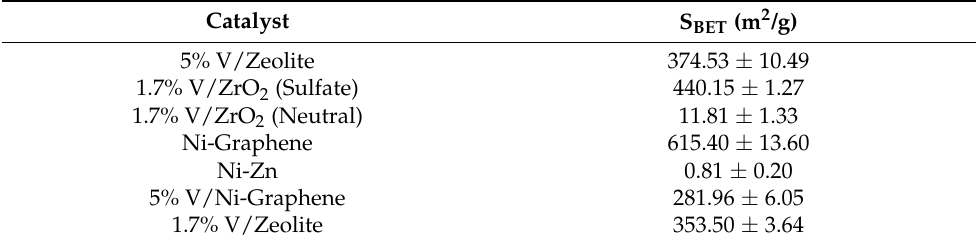
Table 1. Surface area of the different types of